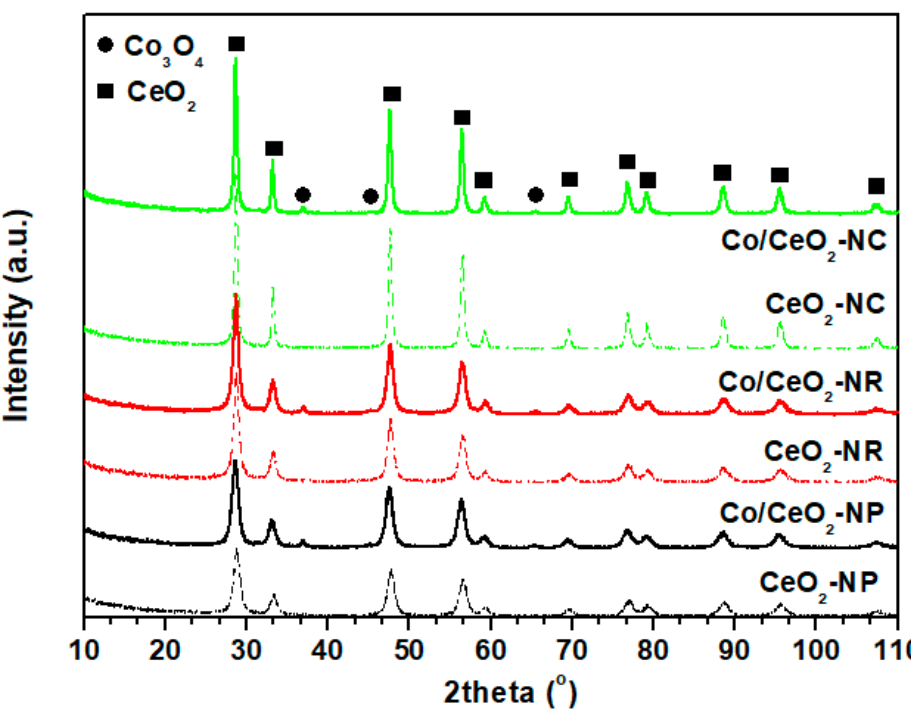
Figure 2. The XRD patterns of the CeO 2 and Co/CeO 2 samples.